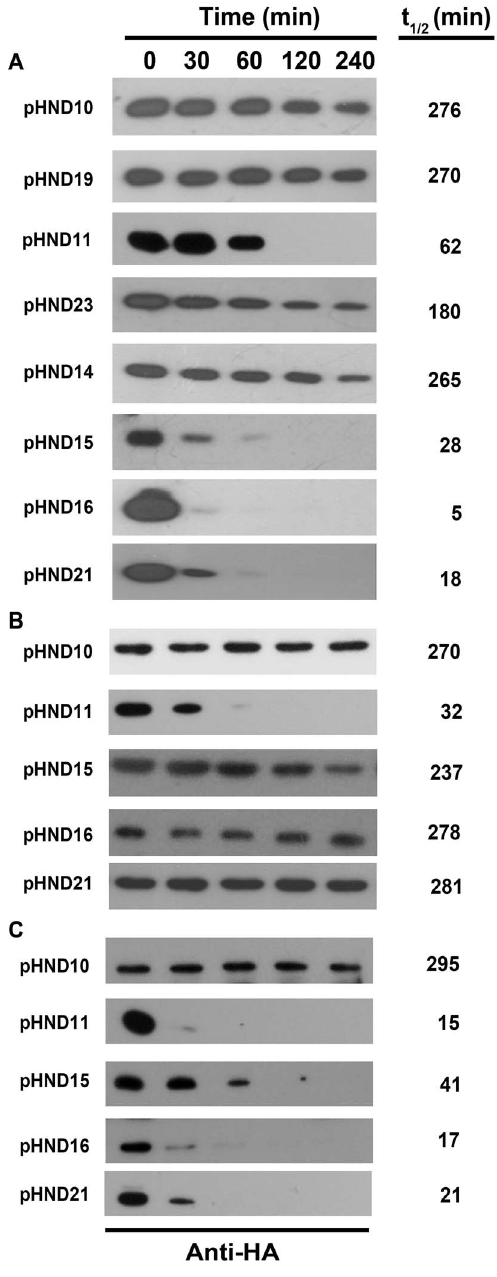
Figure 4. The polyproline PPPP motif and the Y155 residue are required for PhoN2 stability. The intracellular stability of recombi- nant proteins (Table S1) was determined in the D phoN2 mutant strain HND115 complemented with the recombinant plasmids listed in Fig. 3 (Panel A). The relative stability of selected PhoN2-HA recombinant proteins (plasmids pHND10, pHND11, 15, 16 and 21) was evaluated in the E. coli K-12 strain DH10b (Panel B) and in BS176, a virulence plasmid- cured derivative of wild-type S. flexneri strain M90T (Table S1) (Panel C). Stability was measured after protein synthesis had been inhibited by the addition of 100 m g/ml of spectinomycin, as described in Materials and Methods. 0.016% of L-arabinose was used to induce phoN2 ::HA expression. Samples were removed at time points indicated at the top and whole cell extracts were analyzed by Western blot using anti-HA monoclonal antibody. Quantitative measurements were carried out and the calculated half-life of each recombinant protein is shown (right).